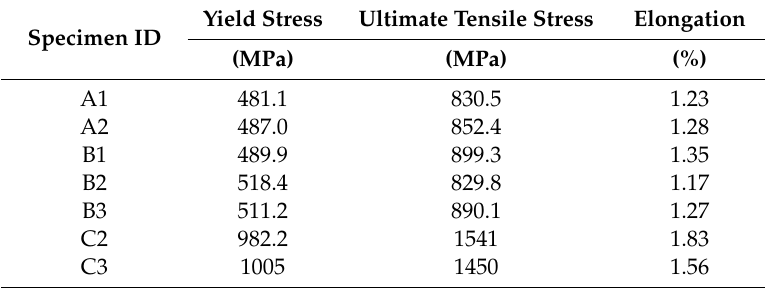
Table 3. Tensile properties of SLM AISI 420 specimens with various build